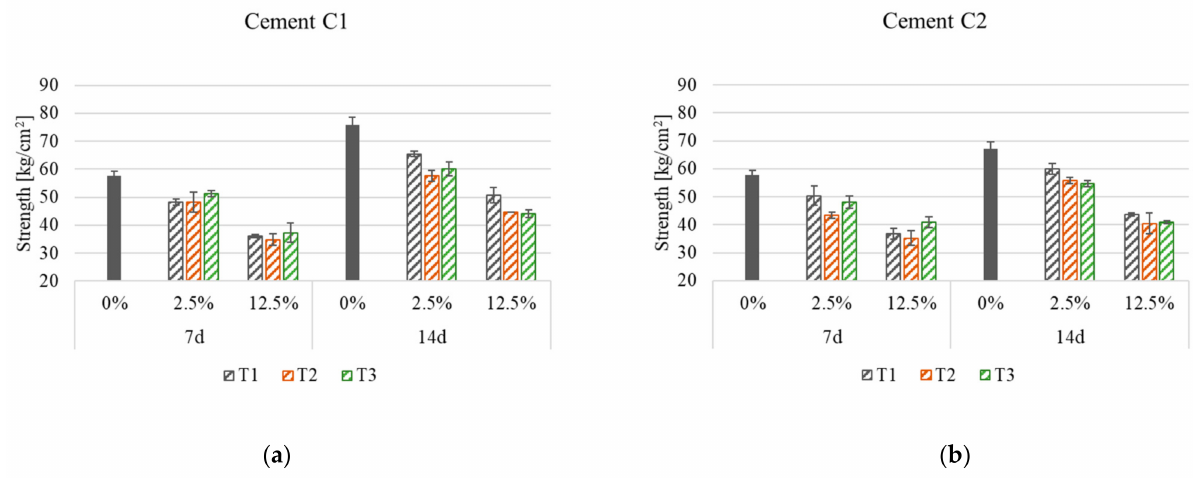
Figure 6. Flexural strength of mortar samples with addition of untreated rubber at 2.5% and 12.5% replacement, after 7 and 14 days: ( a ) cement C1; ( b ) cement C2.